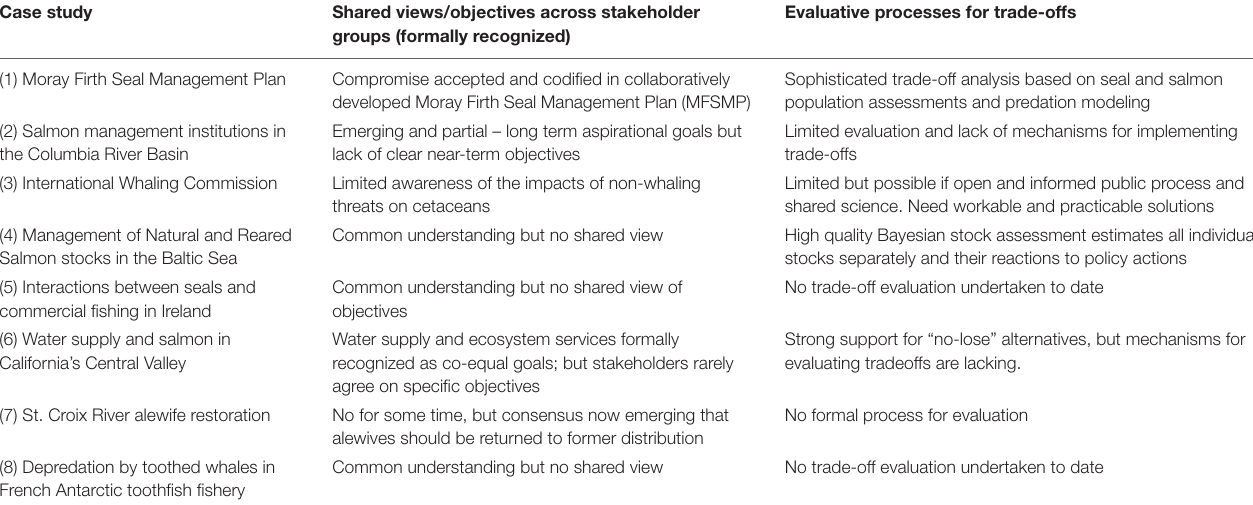
TABLE 6 | Case studies – Stakeholder objectives and processes for evaluating trade-offs. Case